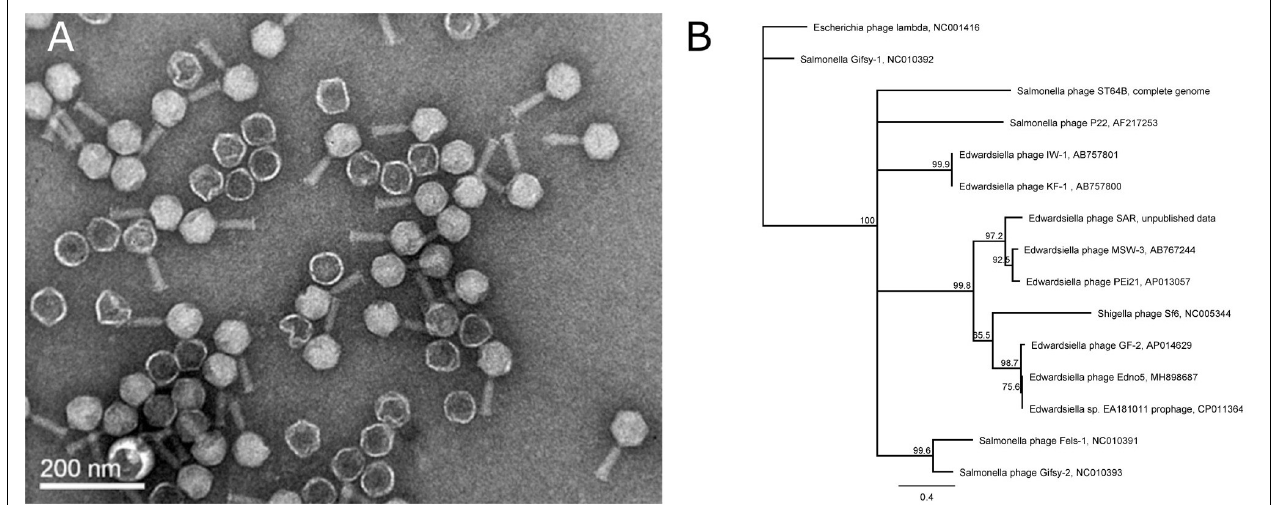
FIGURE 2 | (A) Transmission (TEM) photograph of the phage Edno5 showing a Myoviridae morphology. (B) Phylogenetic tree performed according to Neighbor-Joining method (1,000 bootstraps) that includes bacteriophage Edno5 and 14 more Enterobacteria phages. Temperate phages GF-2, Edno5 and prophage of Edwardsiella sp. EA181011 are clustered